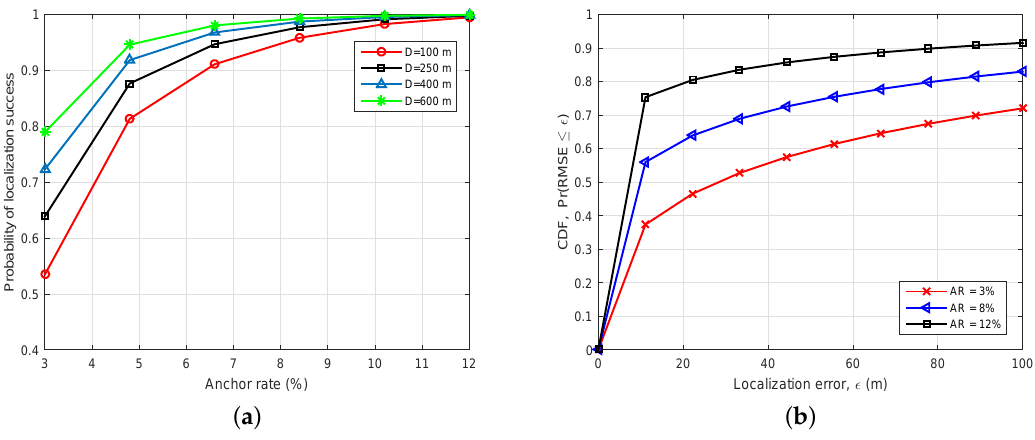
Figure 6. Localization performance of the proposed scheme. ( a ) CDF performance versus AR for several water depths; ( b ) Probability of successful localization versus localization error for several